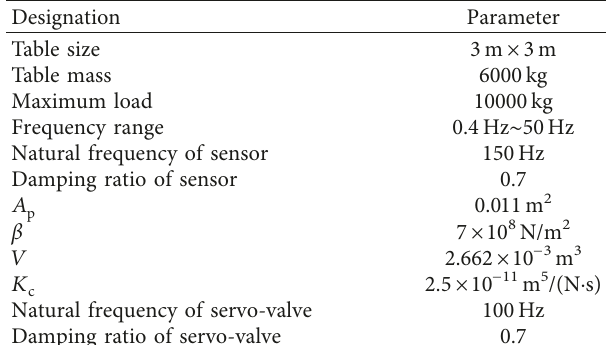
Figure 9: Block diagram of force feedback compensation of the dual shaking tables with specimen. Table 1: Characteristic parameters of dual electrohydraulic servo- shaking tables.